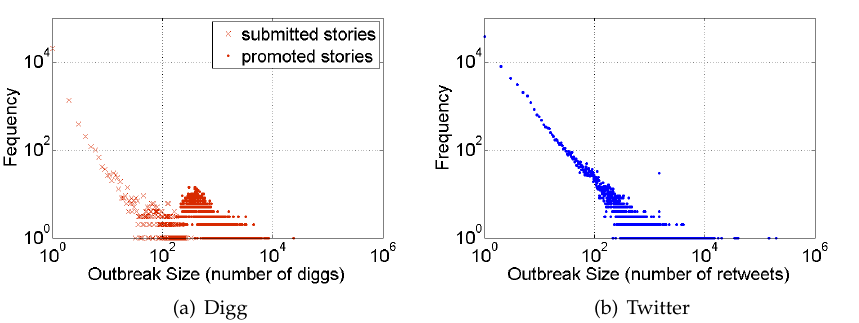
Figure 2. Size of outbreaks in social media. Empirical measurements of the size of contagious outbreaks in social media sites ( a ) Digg and ( b ) Twitter. The x -axis represents the size of outbreak in terms of the number of people who dugg or retweeted specific information, and y -axis reports the frequency of events of that